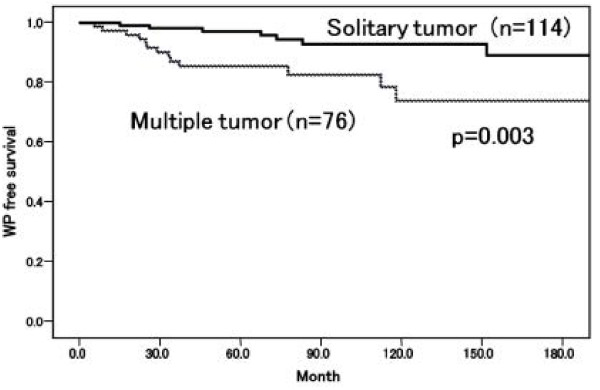
WP-free survival rates by tumor multiplicity.